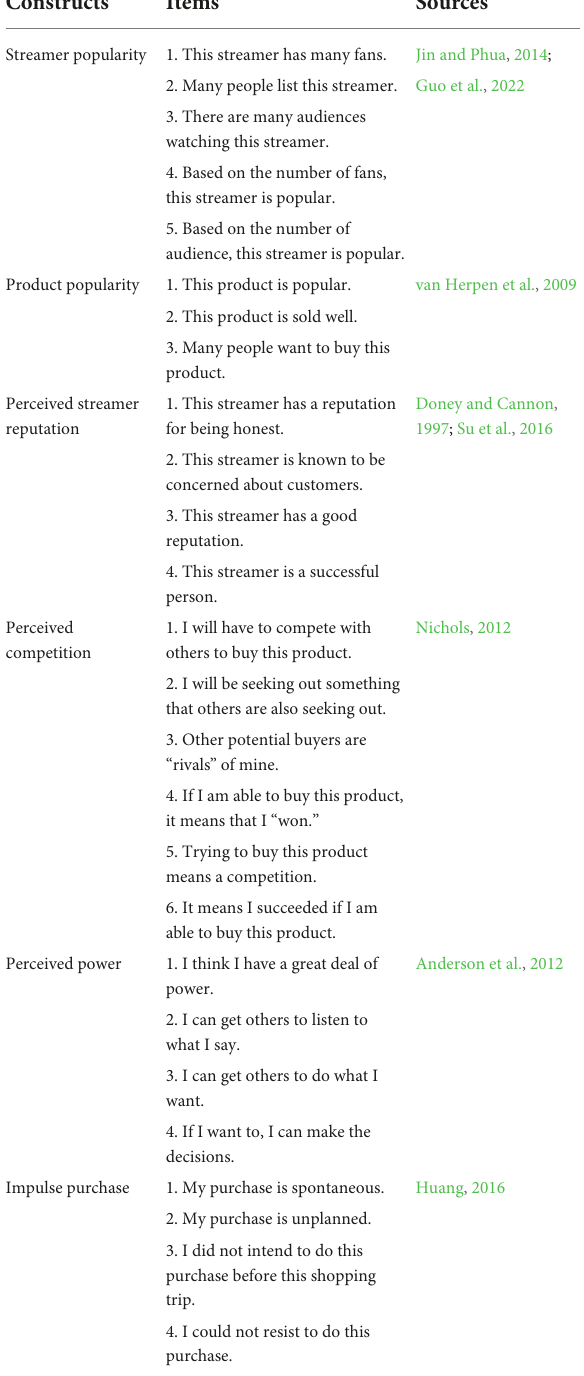
TABLE 2 Measurement items for the constructs. Constructs Items